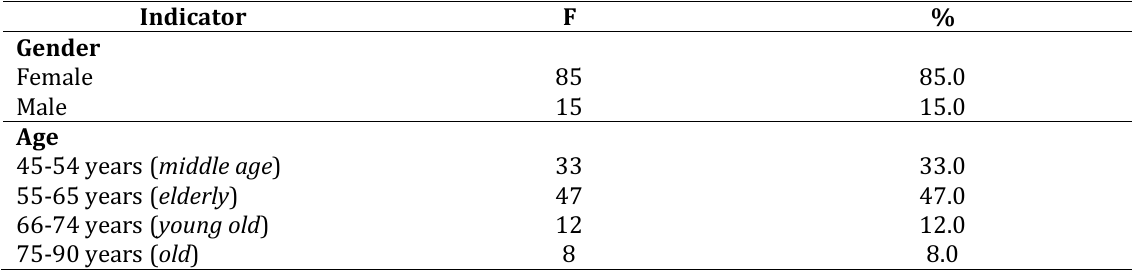
Characteristic Distribution of Respondents by Gender and Age